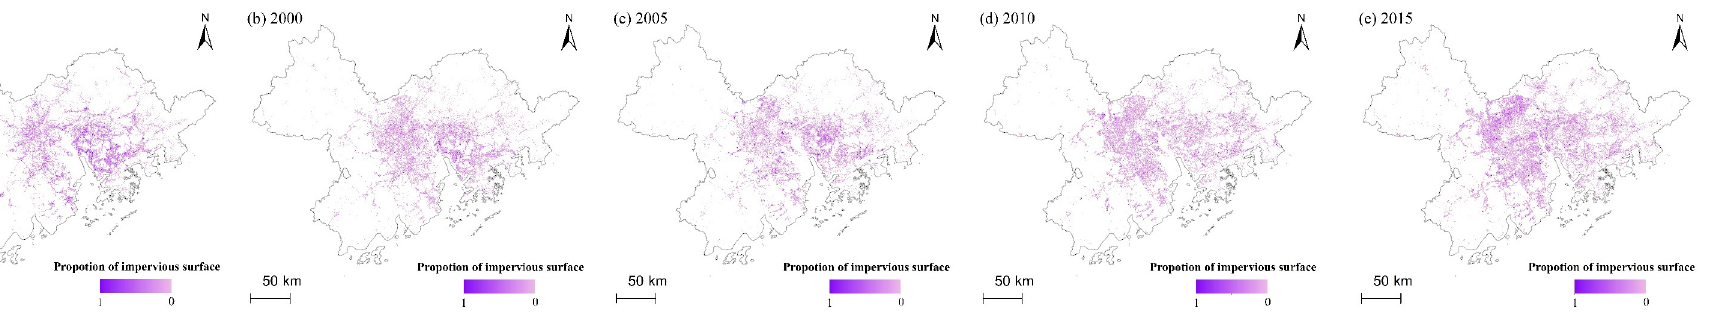
Figure A3. The spatial pattern of the proportion of impervious surfaces: ( a ) 1995, ( b ) 2000, ( c ) 2005, ( d ) 2010, ( e ) 2015.